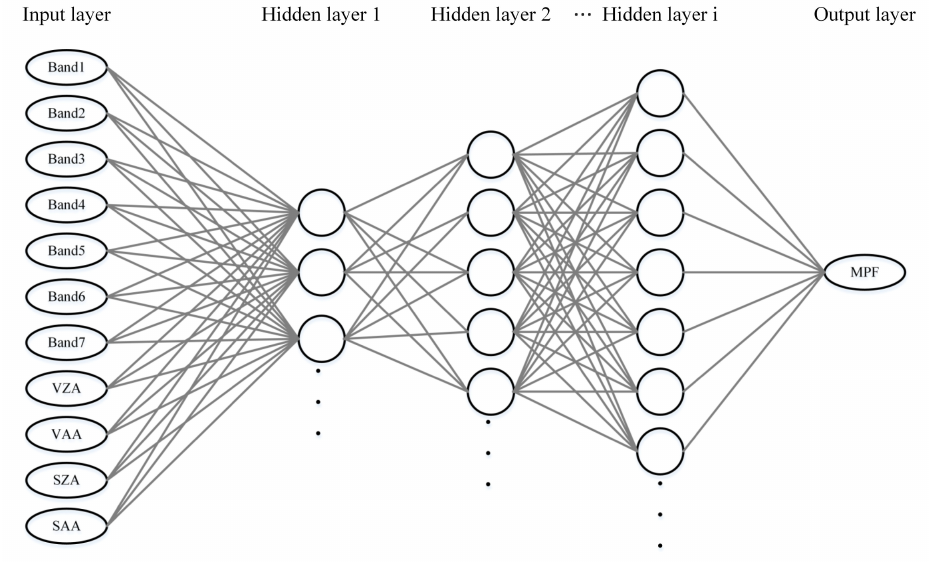
Figure 3. Framework for estimating the MPF using a GA-BPNN model.